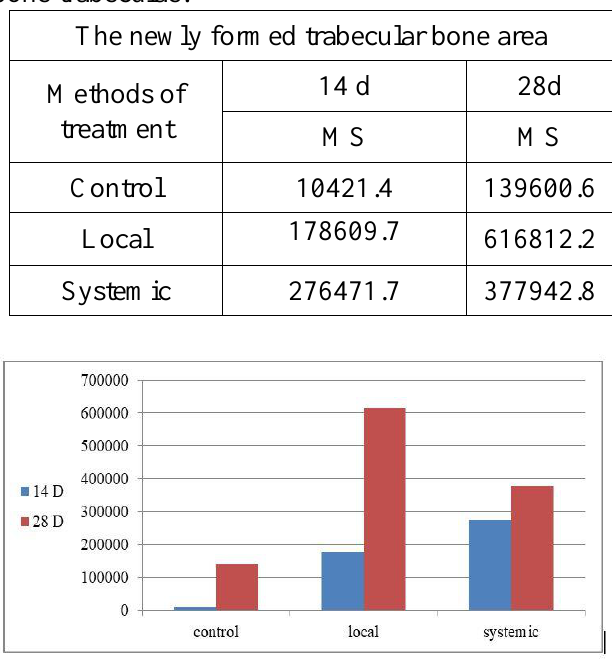
Fig. 6: The histogram of statistical analysis of the thickness of bone